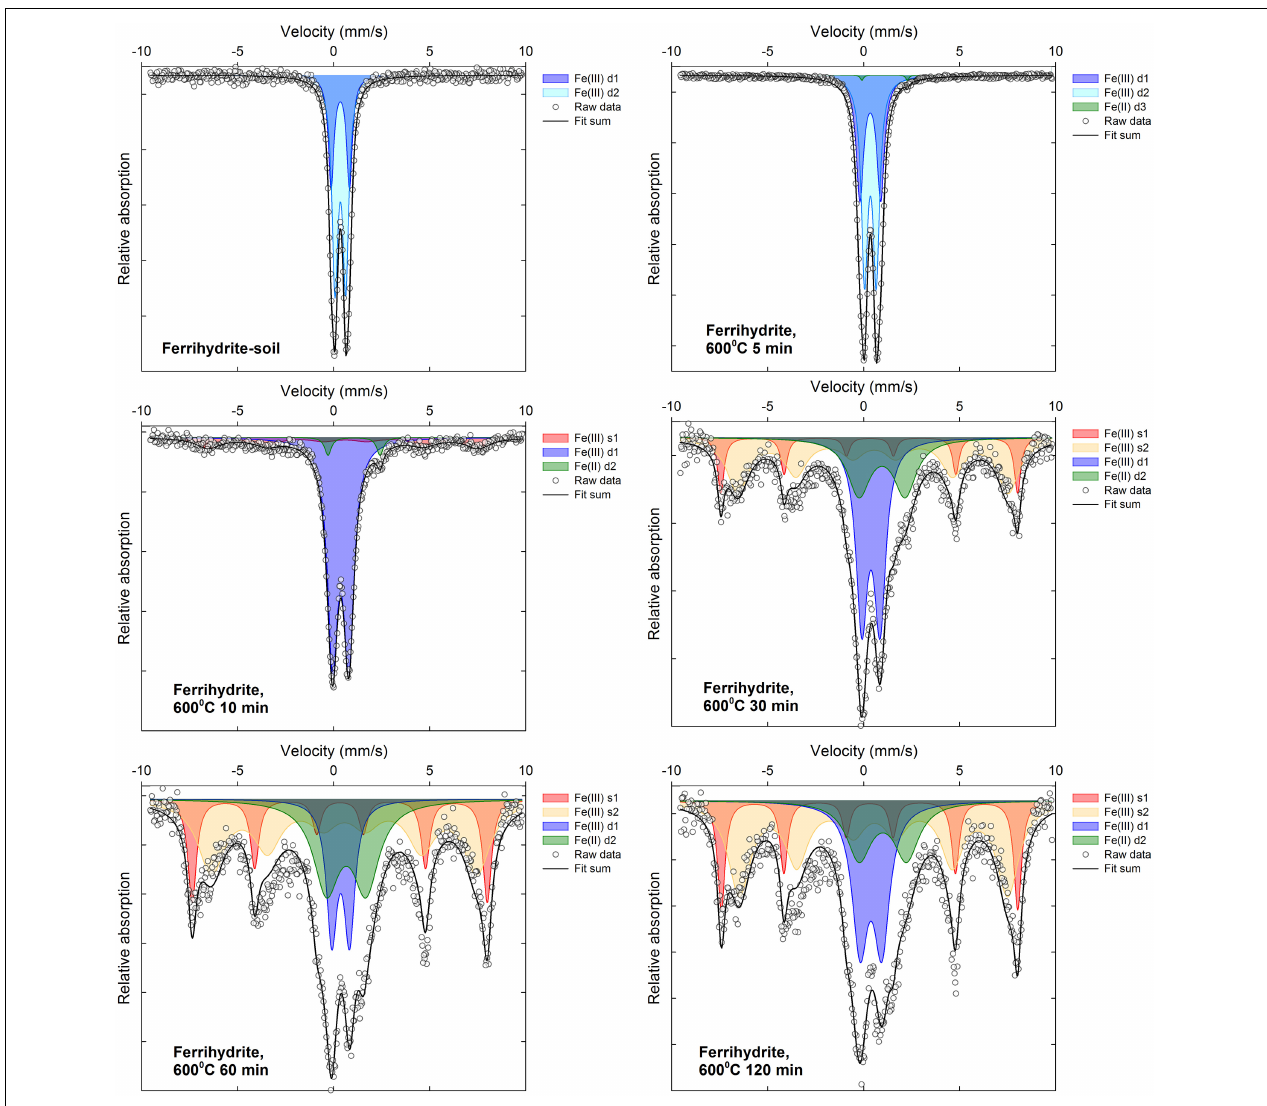
FIGURE 5 | Fitted 57 Fe Mössbauer spectra (292 K) for ferrihydrite:soil treatments, 600 ◦